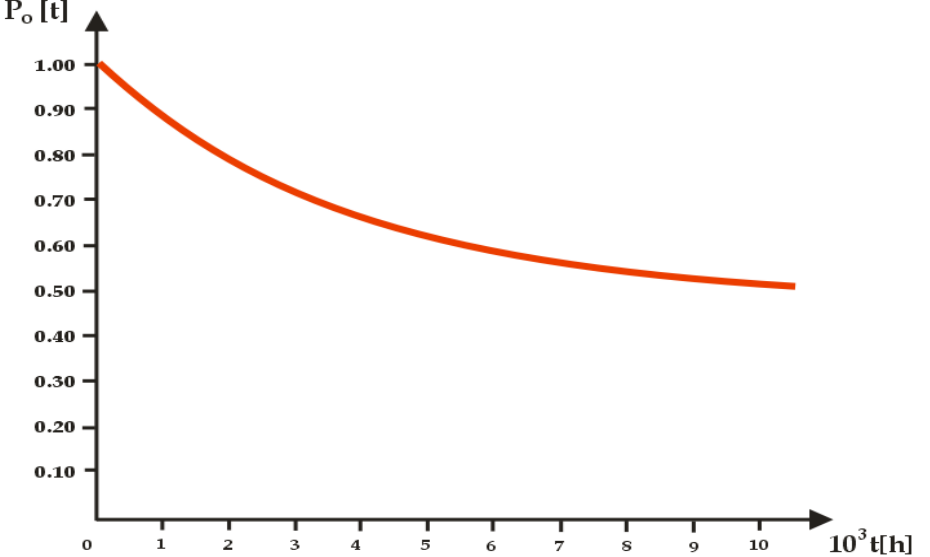
Figure 2. Graph of changes in the probability of the analyzed values of the WFD system remaining for a period of 1 year—own study.